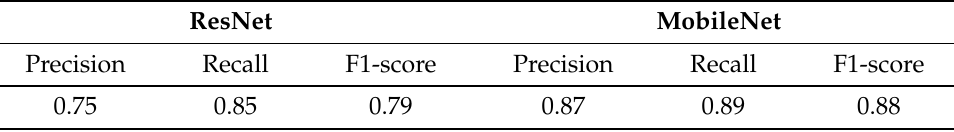
Table 3. Summary of flood damage classification using transfer learning on the basics of ResNet and MobileNet.